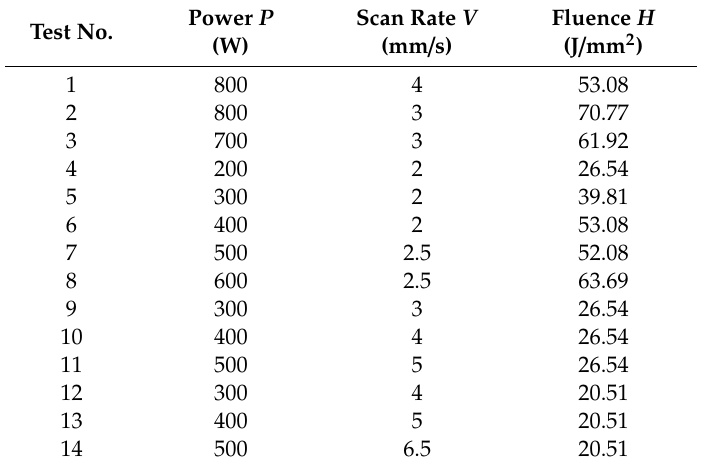
Table 3. Laser treatment parameters for the Cr 3 C 2 –NiCr (CRCZ) coatings.